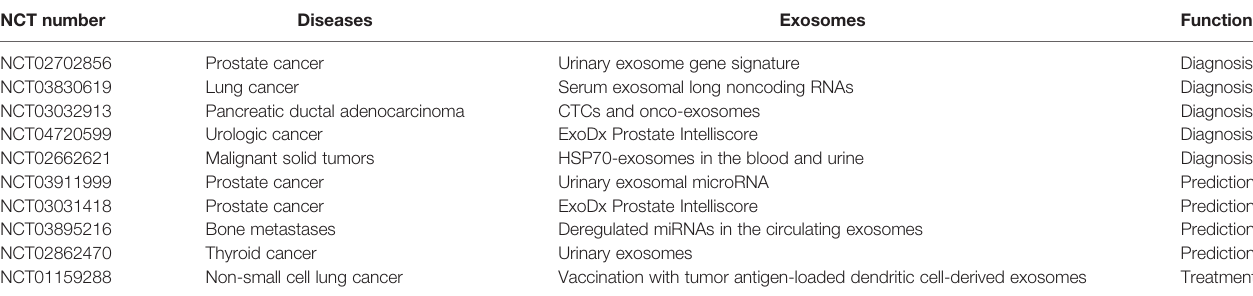
TABLE 2 | Clinical trials on exosomes in other malignant